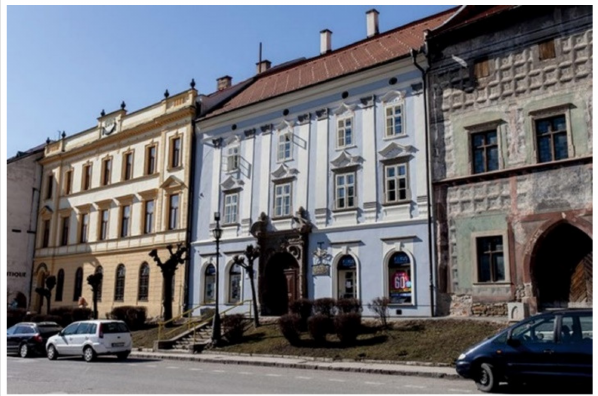
Figure 4. Current state of building no. 43 in Master Paul ´ s Square, view from the square.